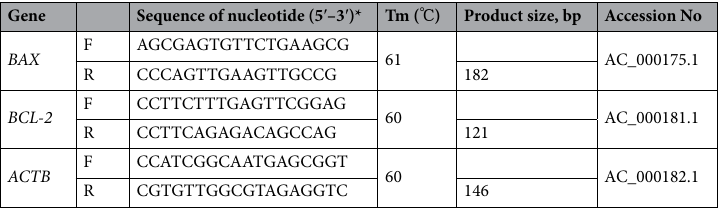
Table 2. Bovine primers used in qRT-PCR. Tm melting temperature, F forward, R